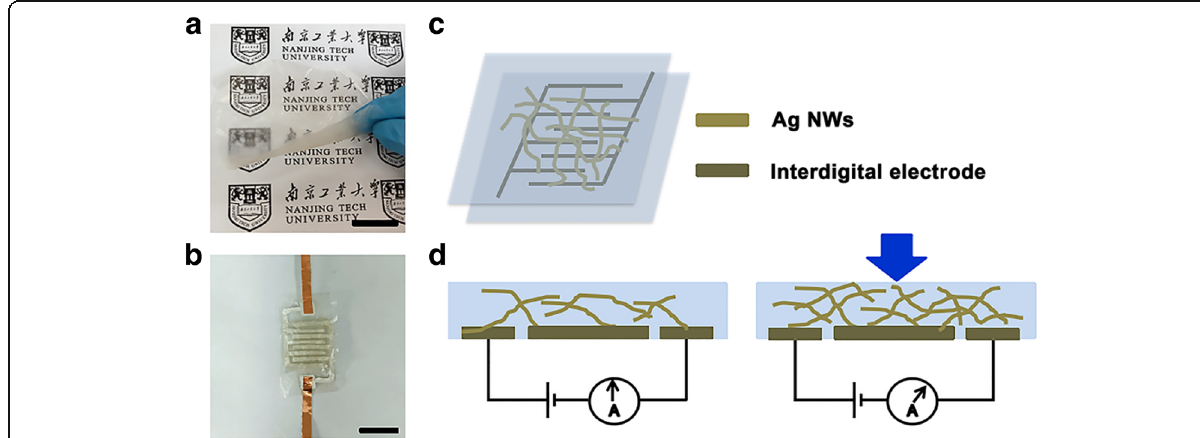
Fig. 3 Fabrication and working principle of the device. a Large-scale uniform and transparent collagen films (scale bar = 1.5 cm). b Photograph of the flexible and transparent pressure sensor (scale bar = 1.0 cm). c Fabrication of a flexible pressure senor based on collagen films. d The illustration of the work principle of the pressure